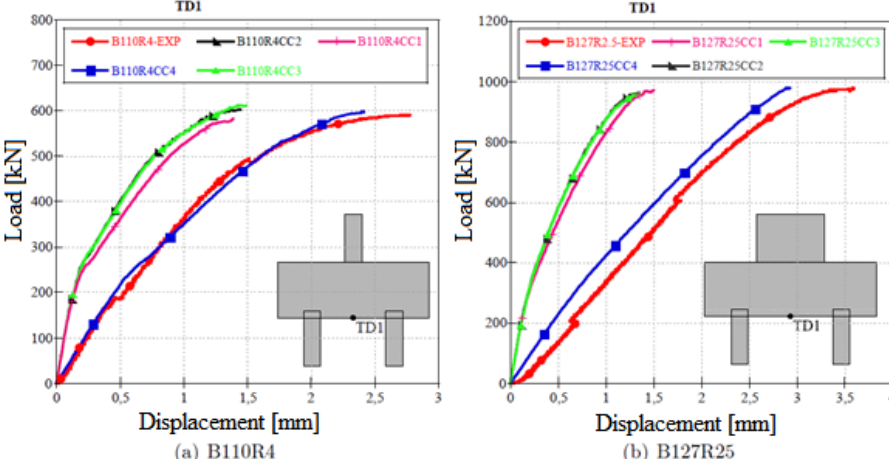
Figure 8. Load versus displacement [TD1] curves of the models of series B110R4 and B127R2.7 for analysis of boundary conditions